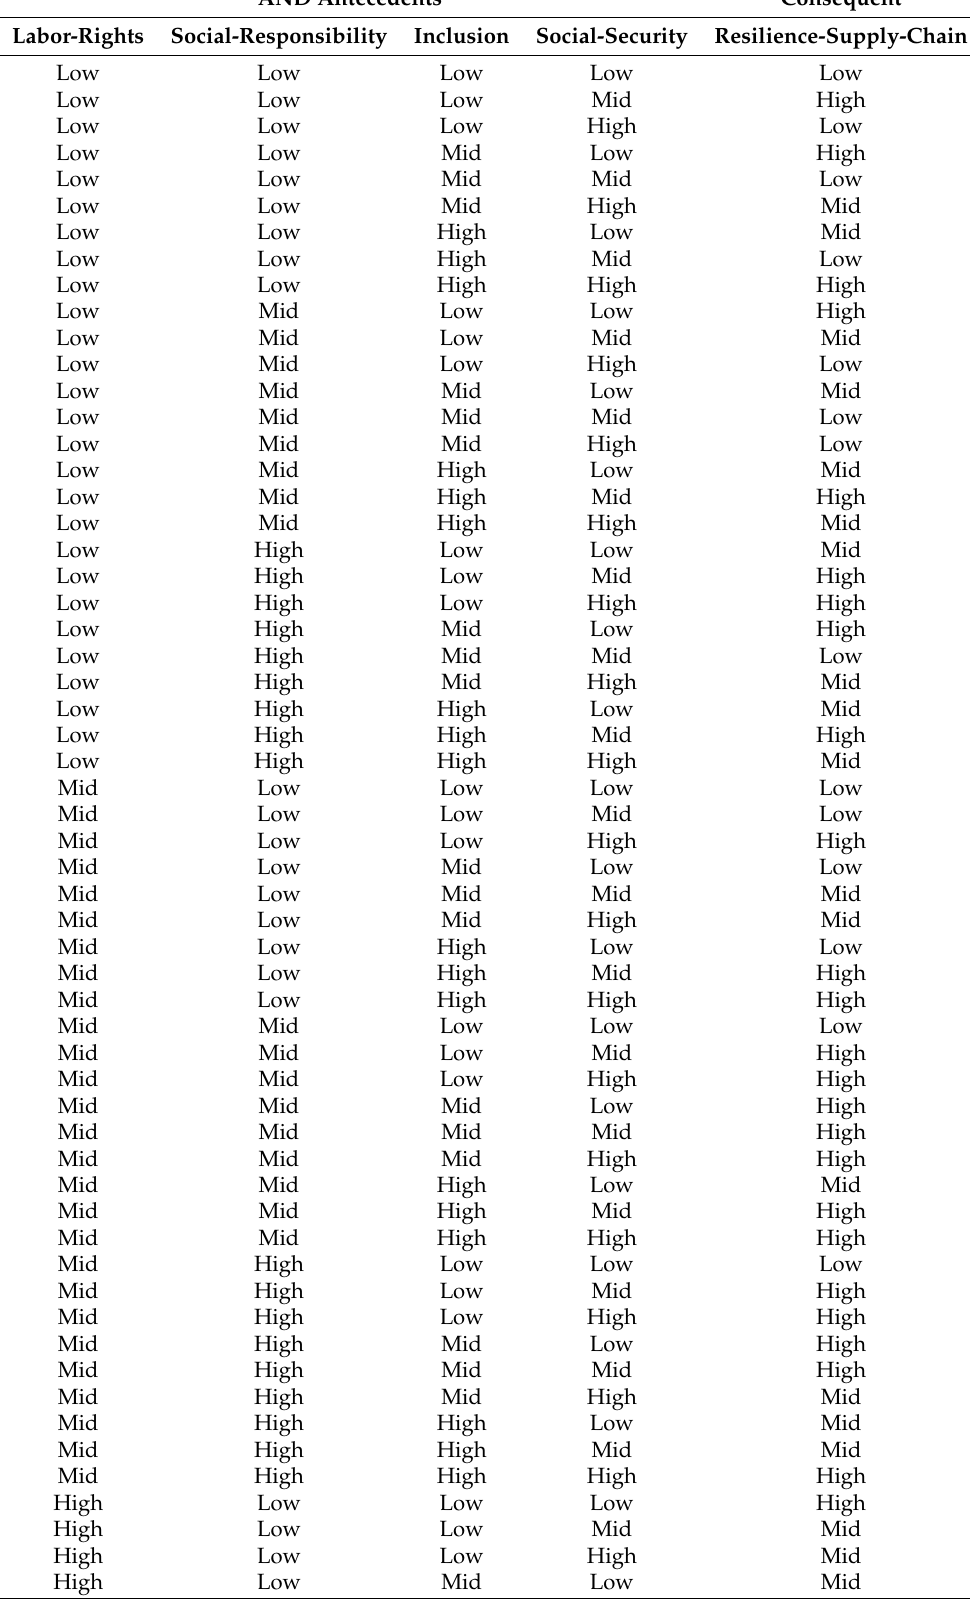
Table 5. The 64 rules of the Fuzzy Knowledge